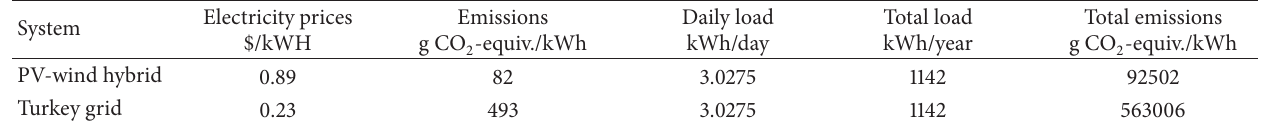
Table 5: The emissions caused by PV-wind hybrid system and grid-fed system.